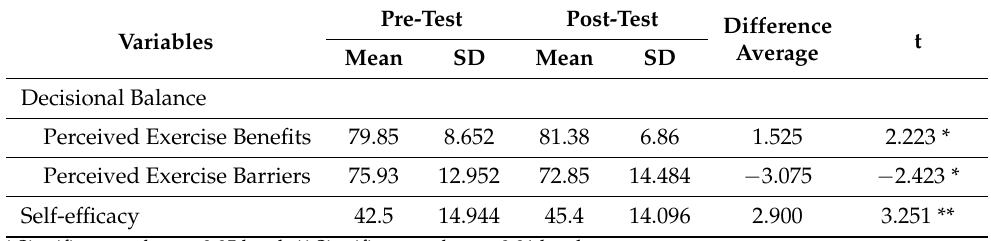
Table 6. Comparing decisional balance and self-efficacy between pre- and post-test (N = 40).